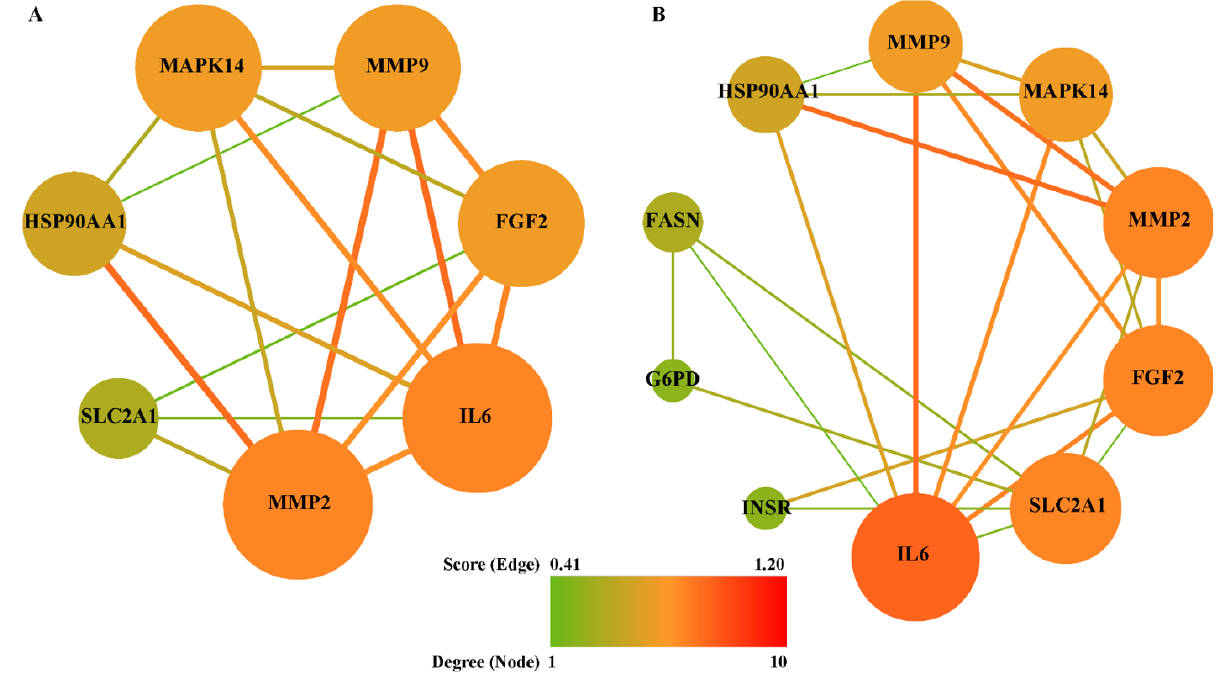
Figure 7. PPI network between common targets. ( A ) Inflammation, ( B ) oxidative stress. The nodes represented targets and edges represented interaction among targets. The node size and color were represented with degree, while edge size and color were represented with combined